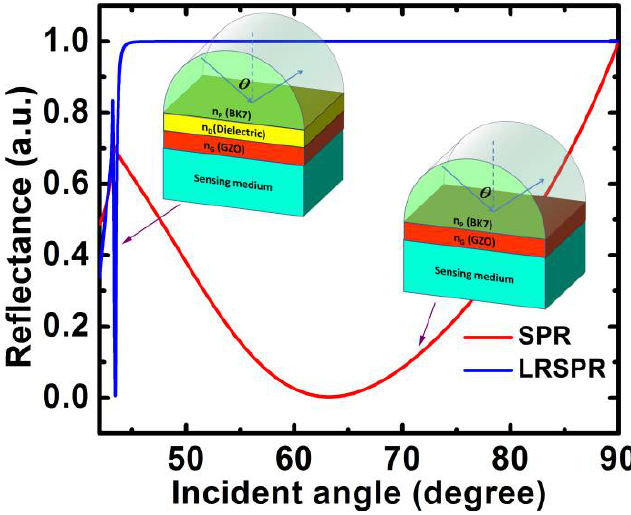
Figure 2. Variation in the reflectance with the incident angle for sensors based on GZO SPR and GZO LRSPR. GZO